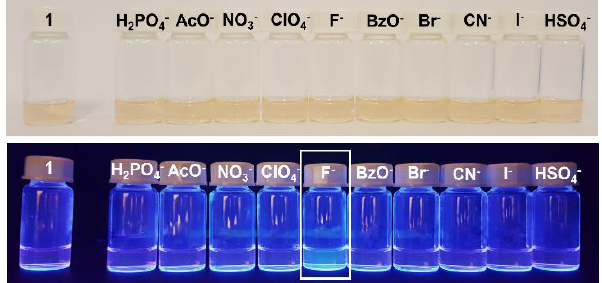
Figure 3. BODIPY derivative 1 solutions in the presence of various anions, in acetonitrile, under natural light (above) and UV radiation at λ max = 365 nm (below).